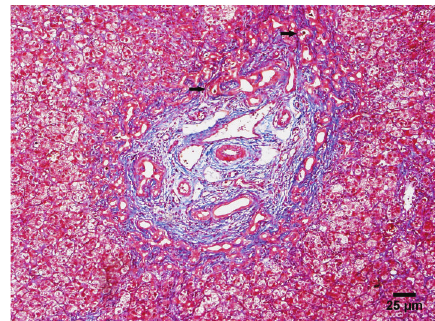
Figure 1. Photomicrograph showing the main histological fi ndings of biliary atresia A portal space with ductular proliferation and biliary plugs (arrows) can be seen. Masson trichrome stain, (cid:1) 100.